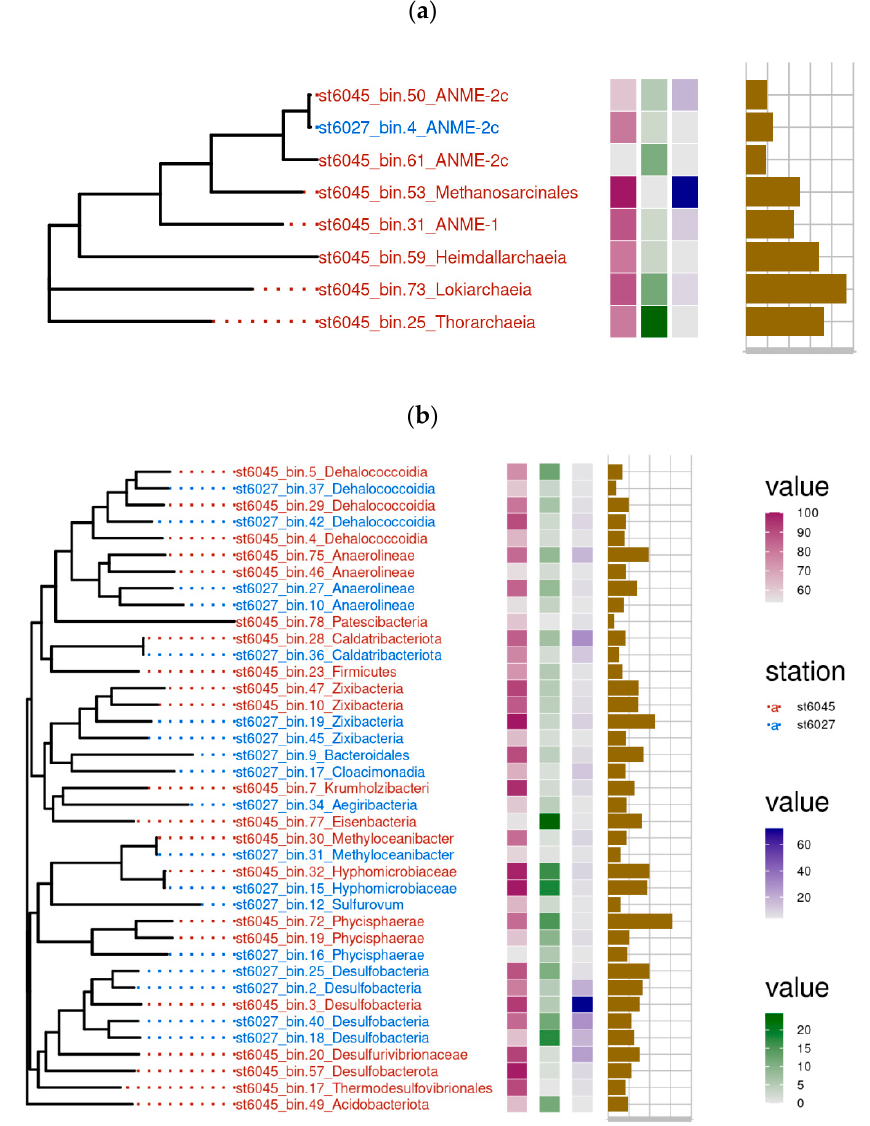
Figure 6. The main characteristics of obtained MAGs of archaea ( a ) and bacteria ( b ) at stations 6027 Figure 6. Metagenomic analysis of archaea ( a ) and bacteria ( b ) at stations 6027 и 6045. and 6045. First column—completeness of the assembled MAG (%); second column—contamination (%); third column—average sequencing coverage (fold); fourth column—MAG size (one cell—1 Archaea of the phylum Halobacteriota , represented by 4 MAGs, were among the most numerous members of the microbial community at st. 6045. The bin53 genome was re- sponsible for 3% of the metagenome and was closely related to ANME-2 cluster archaeon HR1 ASM292619v1(AAI 95.79%), revealed in a bottom methane seep in the Pacific Ocean and assigned to the ANME2 group. Two other bins, bin61 and bin50, were also assigned to ANME2, while bin31 belonged to ANME1. In another metagenome from st. 6027, the